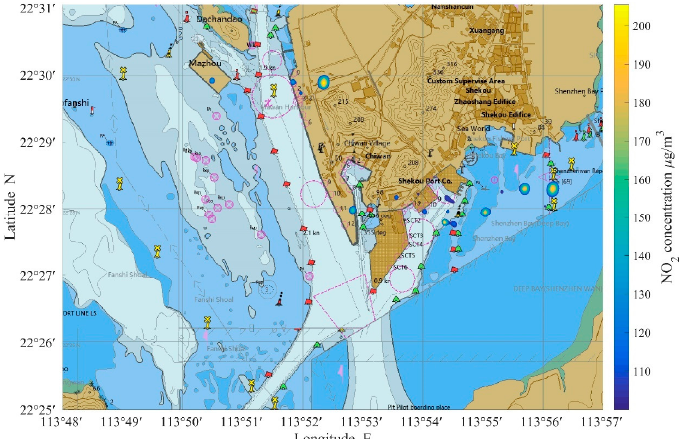
Figure 12. NO 2 concentration distribution at 2:00 (greater than 100 μ g/m 3 ).